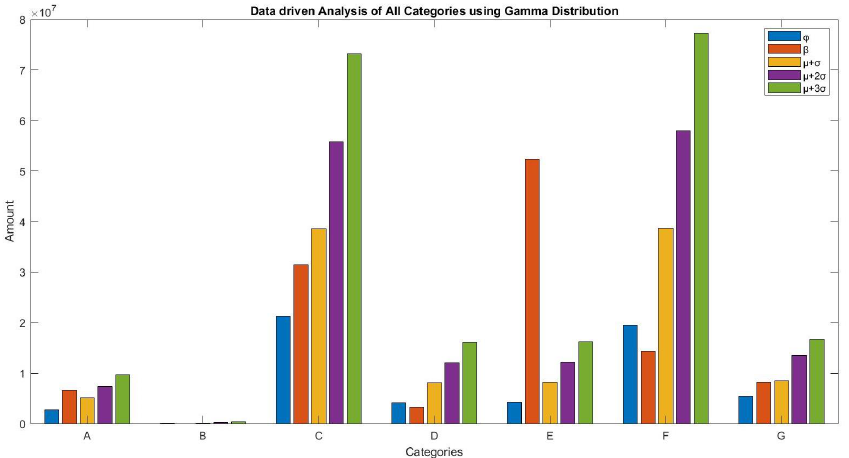
Figure 19. Data Driven Analysis using Gamma